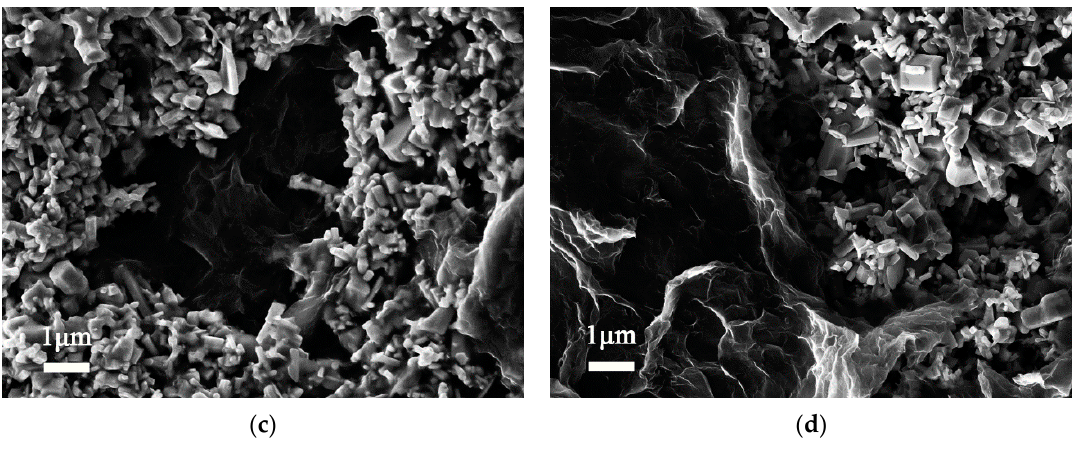
Figure 3. Typical SEM images of ( a ) PVP-RGO, ( b ) ZnO, ( c ) PVP-RGO/ZnO, and ( d ) ZnO/PVP-RGO films.